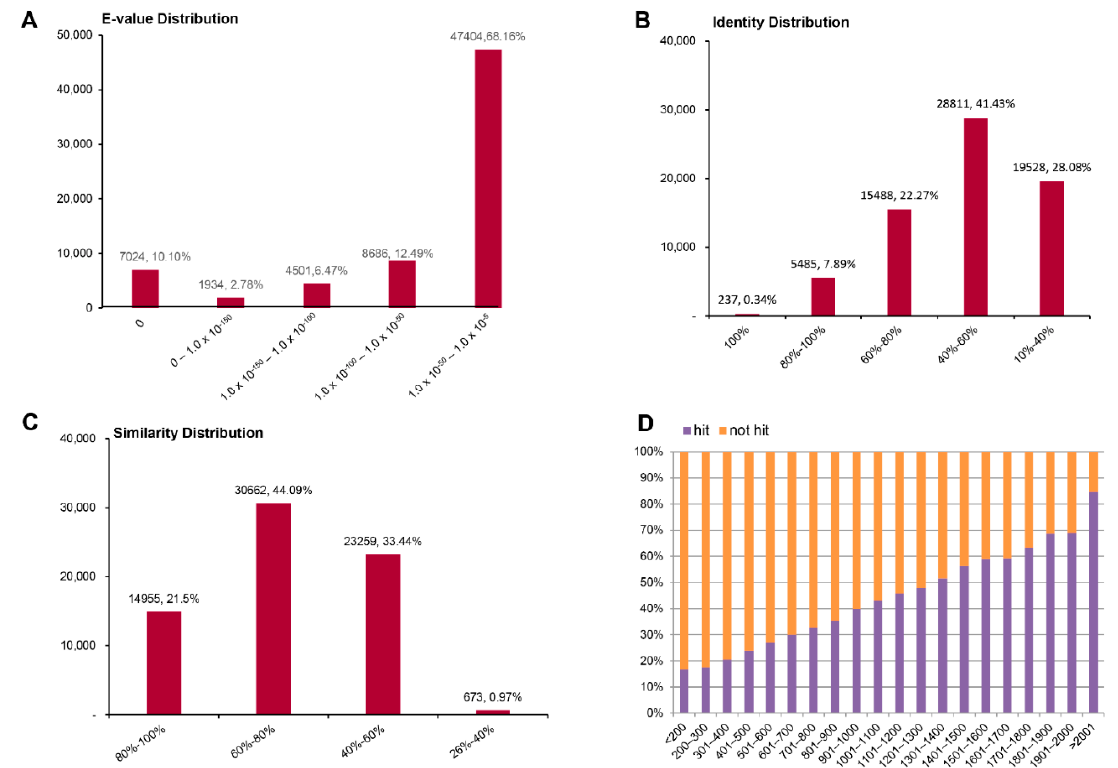
Figure 5. PANM-DB homology classification of A. quelpartensis unigenes. ( A ) E -value distribution; ( B ) Identity distribution; ( C ) Similarity distribution; ( D ) Unigene hit or non-hit ratio.